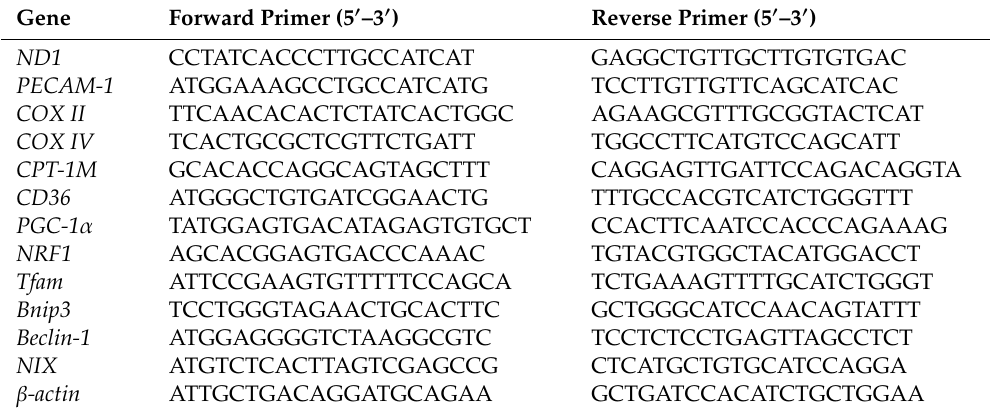
Table 1. List of primers used in the